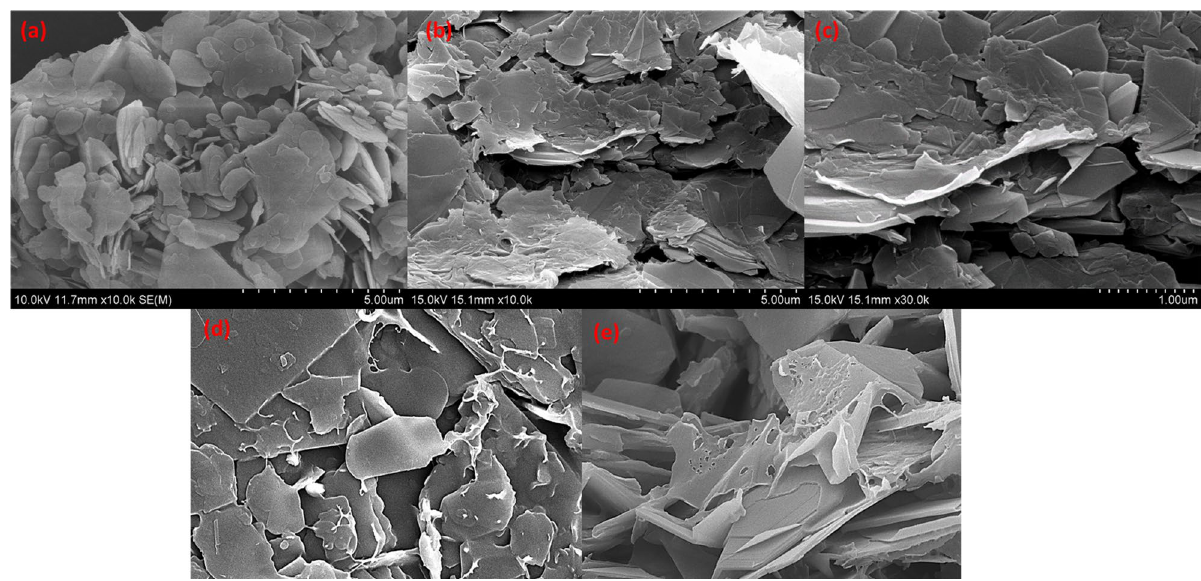
Figure 5. FE-SEM images of ( a ) BN, ( b , c ) BNNS/PVA, ( d , e ) borax: